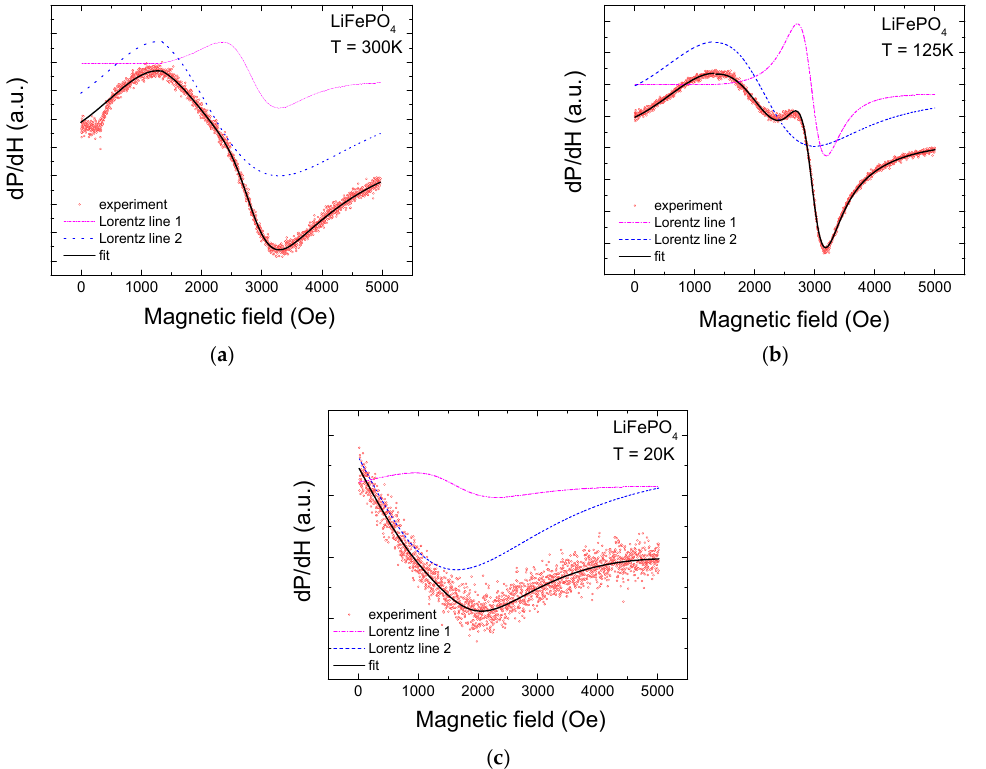
Figure 3. Decomposition of the ESR spectra of LiFePO 4 at different temperatures: ( a ) T = 300 K, ( b ) T = 125 K, and ( c ) T = 20 K.